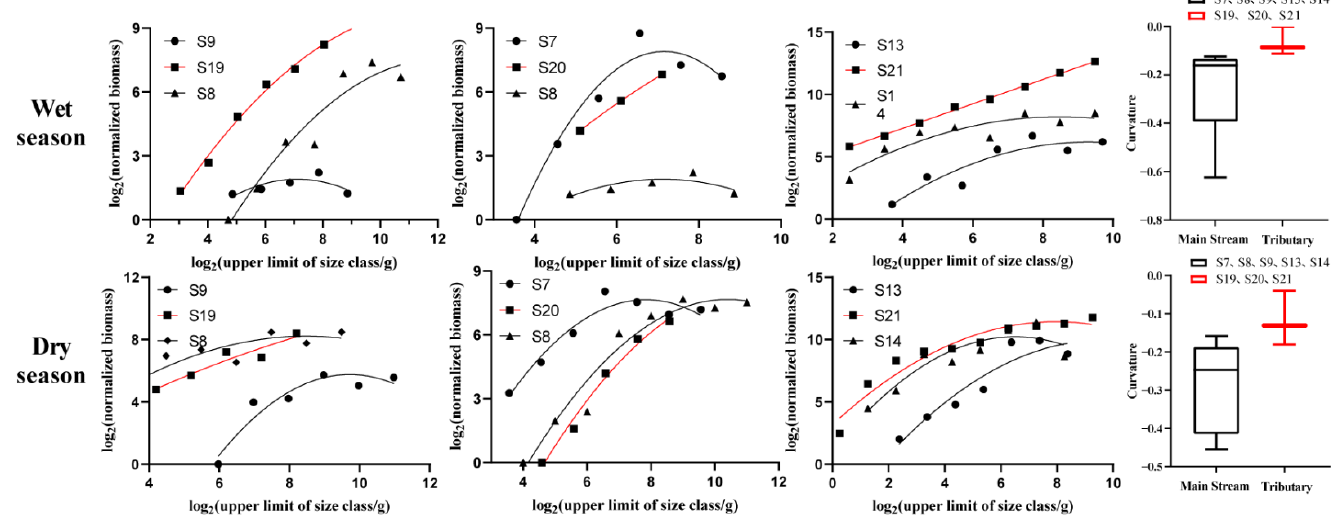
Figure 7. Standardized biomass particle-size spectrum of fish in the main stream and tributaries of the upper Jinsha River in different seasons and box plot of curvature of the main stream and tributary stream (horizontal line from top to bottom showing top edge, median, and bottom edge). Table 2. Spatial comparison of normalized biomass particle-size spectrum of fish in different sea- sons in the upper reaches of the Jinsha River.